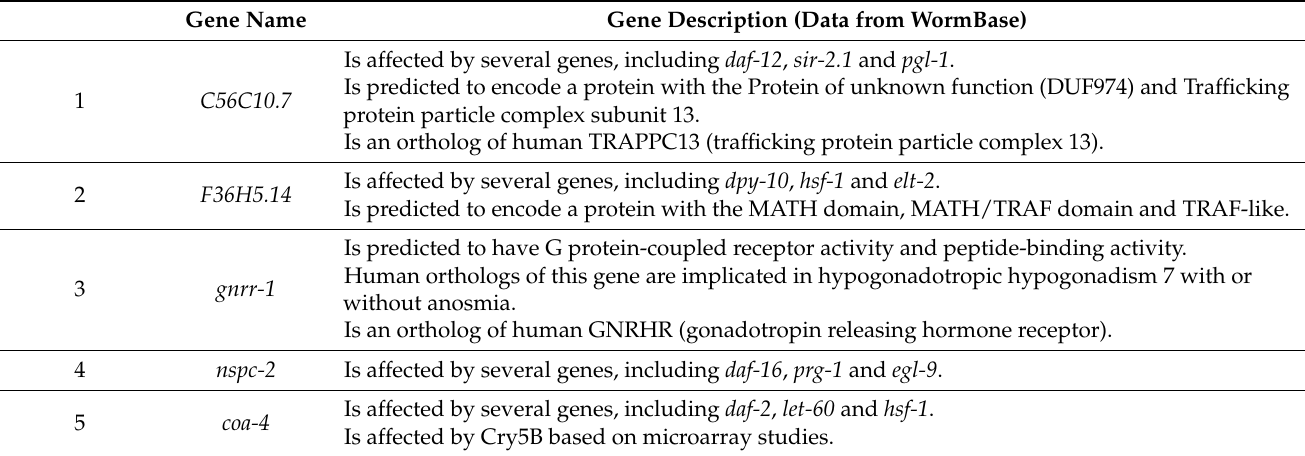
Table 1. Top 5 upregulated genes in response to TG.